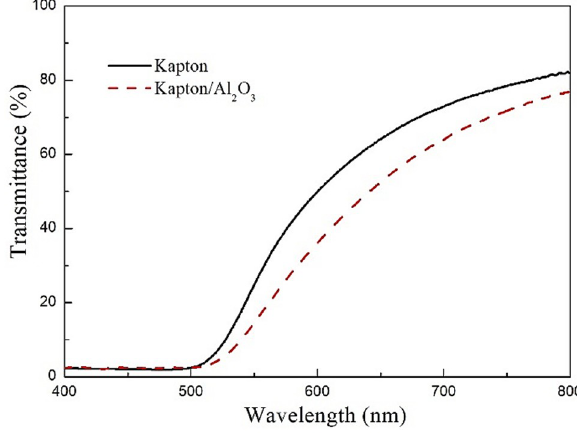
Figure 5. Optical transmittance of the Kapton film and Kapton / Al 2 O 3 surface nanocomposite